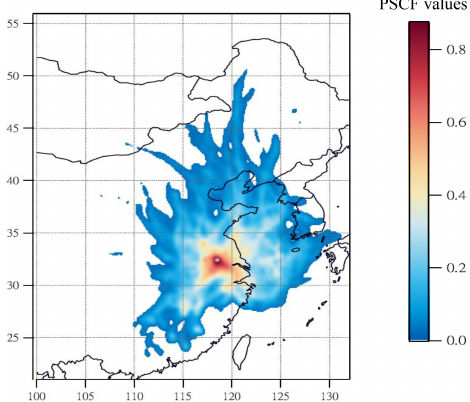
Figure 4. The PSCF maps of high-nitrate